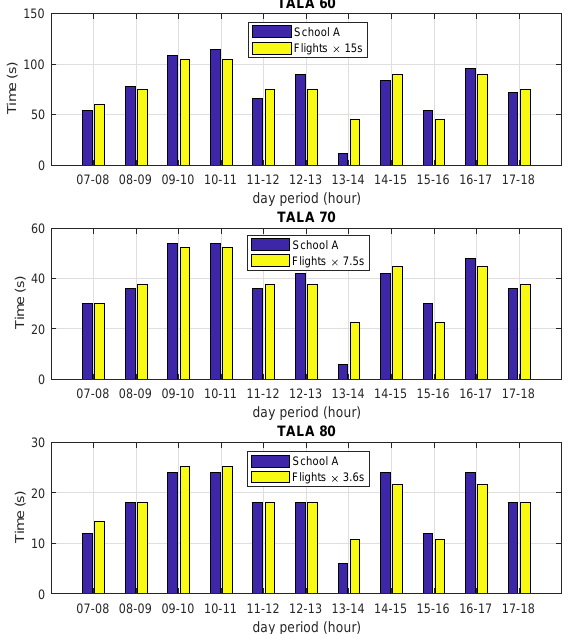
Figure 9: Comparison of TA metric and the total interruption time promoted by the number of flights per